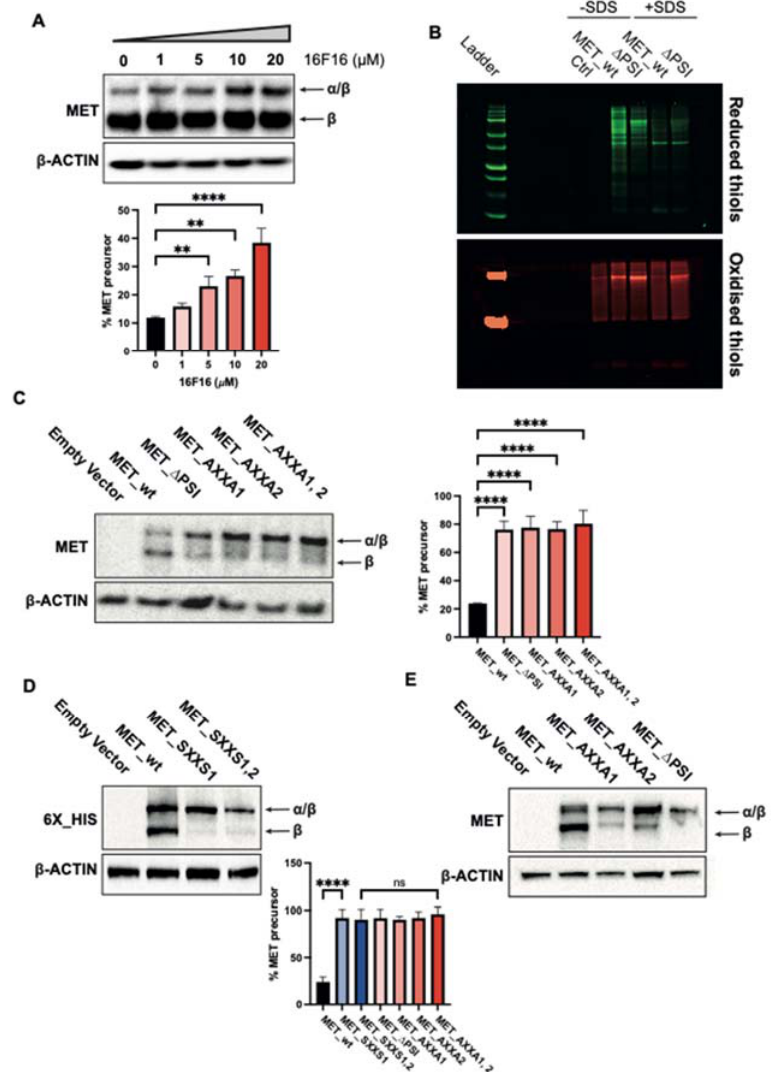
Figure 3. The MET PSI domain is indispensable for MET maturation through the CXXC motifs . ( A ) EBC1 cells were treated with indicated concentrations of 16F16 for 48 h or DMSO as vehicle. Proteins were resolved in 6% SDS ‐ PAGE, and MET expression was assessed by Western blot. ( B ) TOV112D